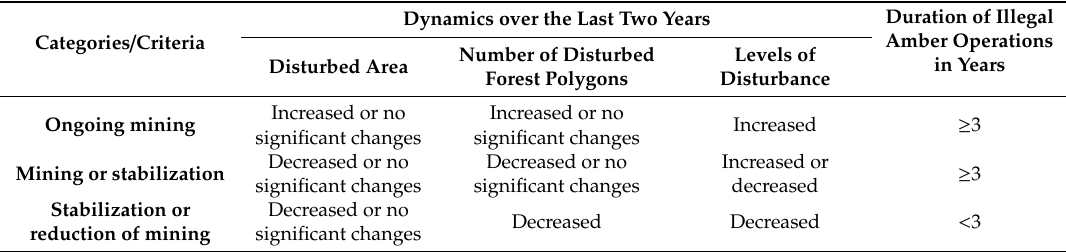
Table 8. The categories of FMUs a ff ected by illegal amber mining and the associated criteria for their